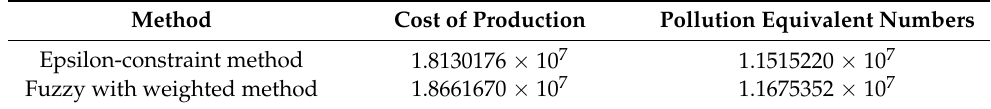
Table 7. Cost and pollution results of the two